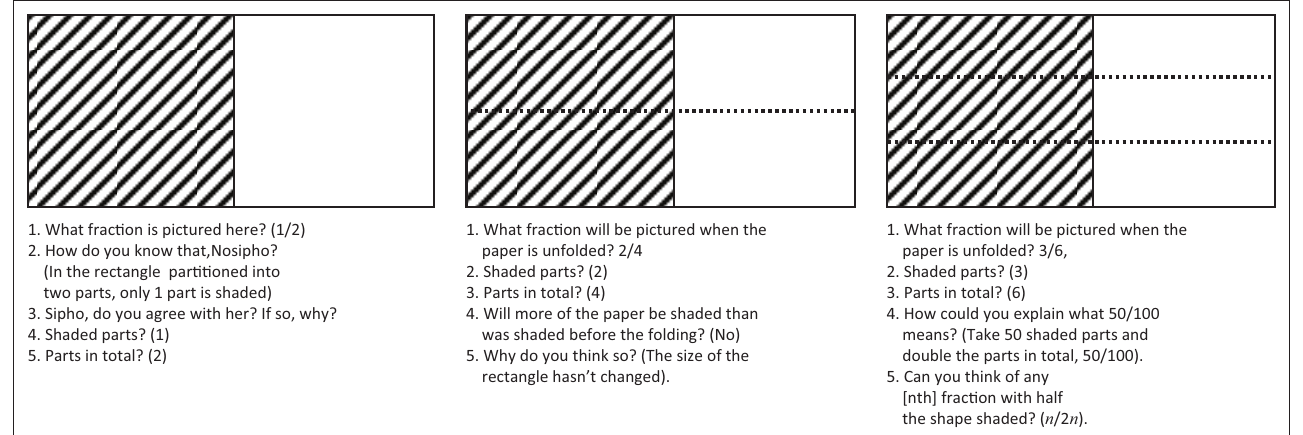
FIGURE 3: Development of a general statement about equivalent